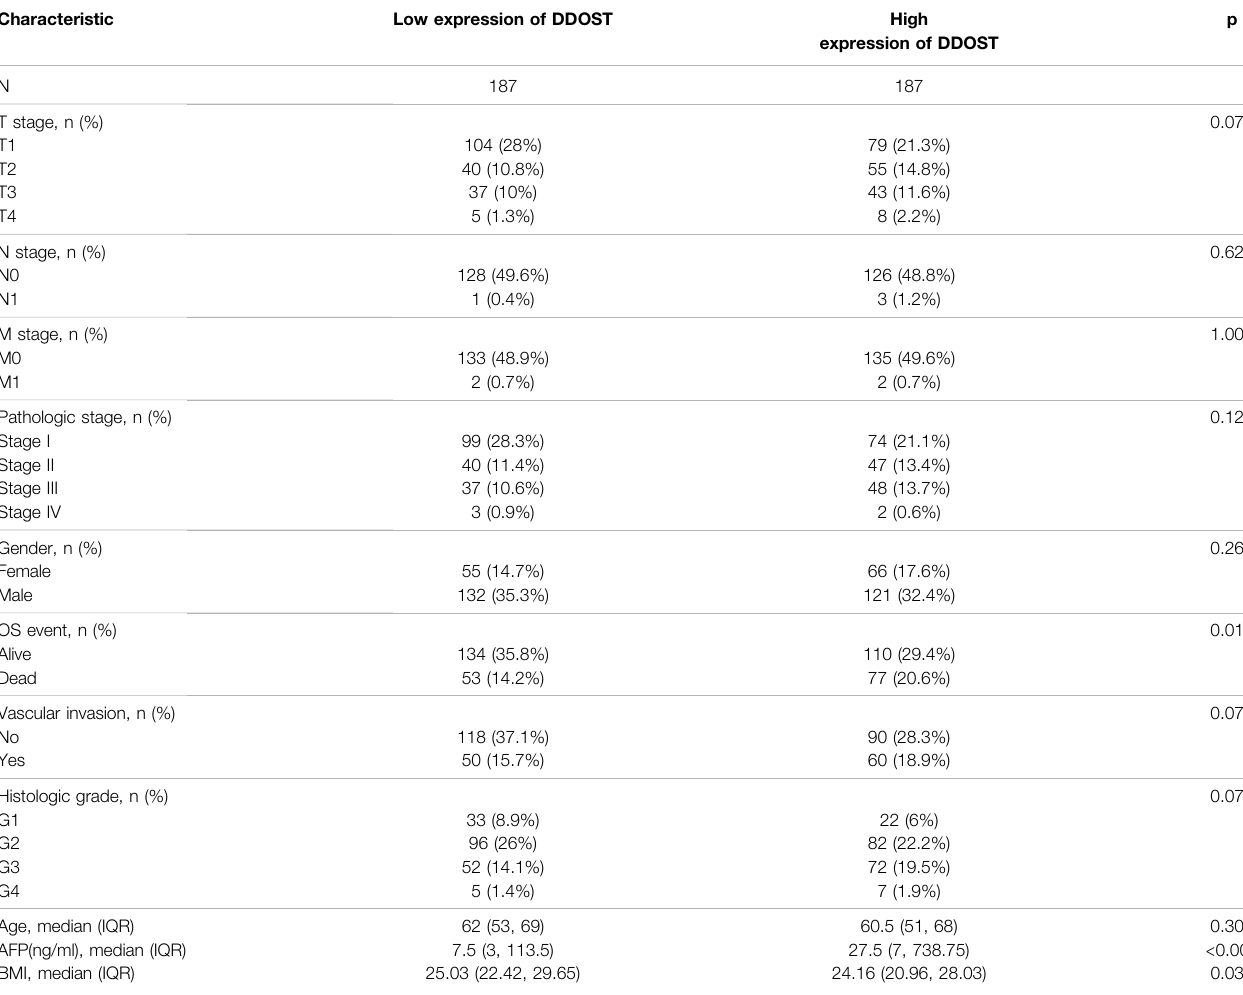
TABLE 1 | Demographic and clinicopathological parameters of high and low DDOST expression group patients with hepatocellular carcinoma in TCGA-LIHC. Characteristic Low expression of